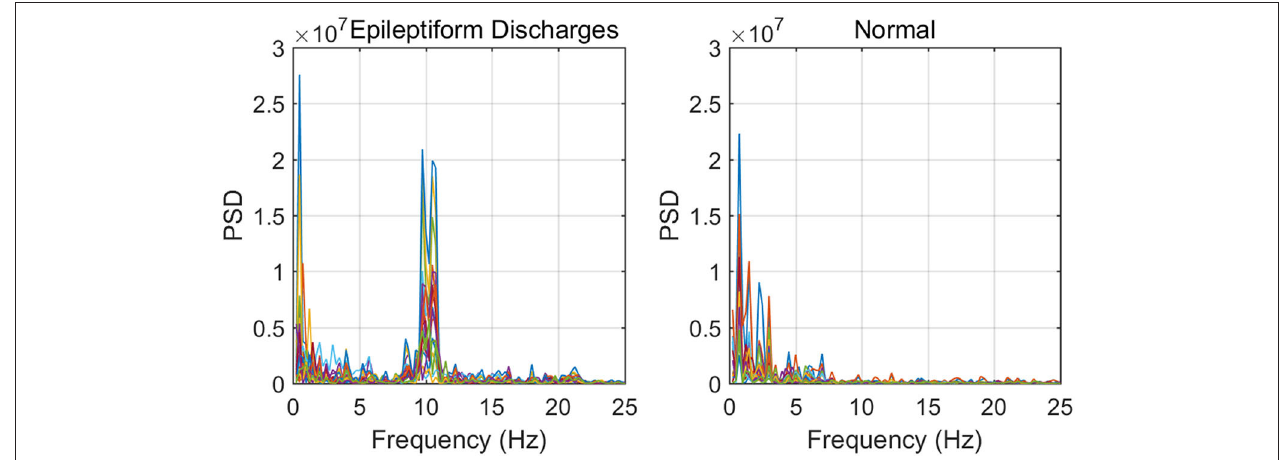
FIGURE 7 | Typical PSD curves for epileptiform discharges and normal EEG showing that the relative energy of the alpha wave component for epileptiform discharges is often larger for that of normal EEGs.